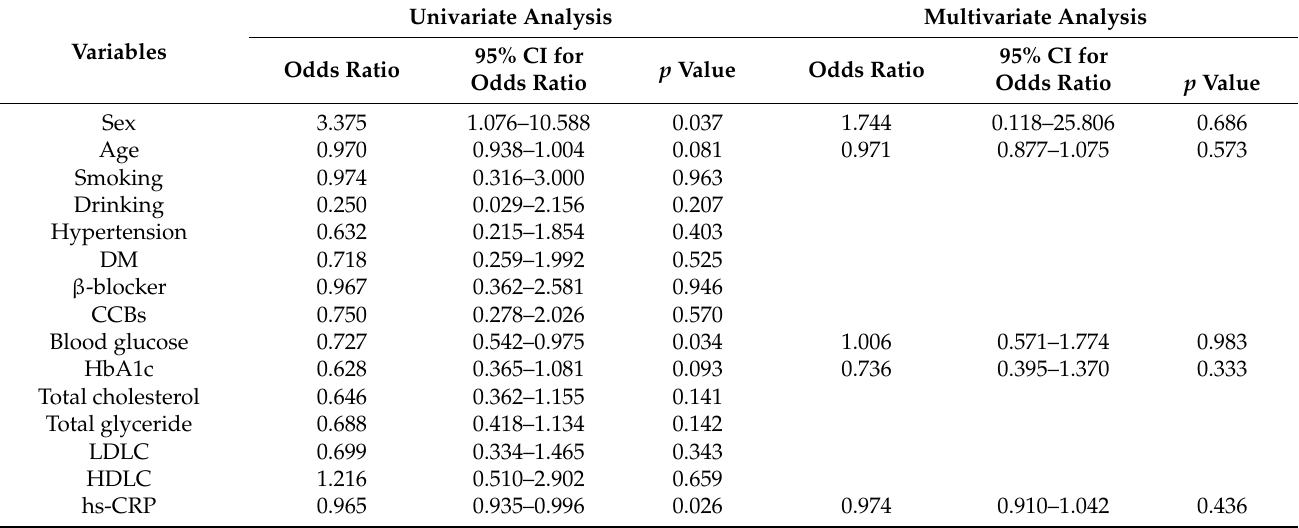
Table 2. Univariate and multivariate logistic regression analyses for predicting the incidence of CAS in clinical patients. The odds ratio represents the risk change per 1 unit increase in